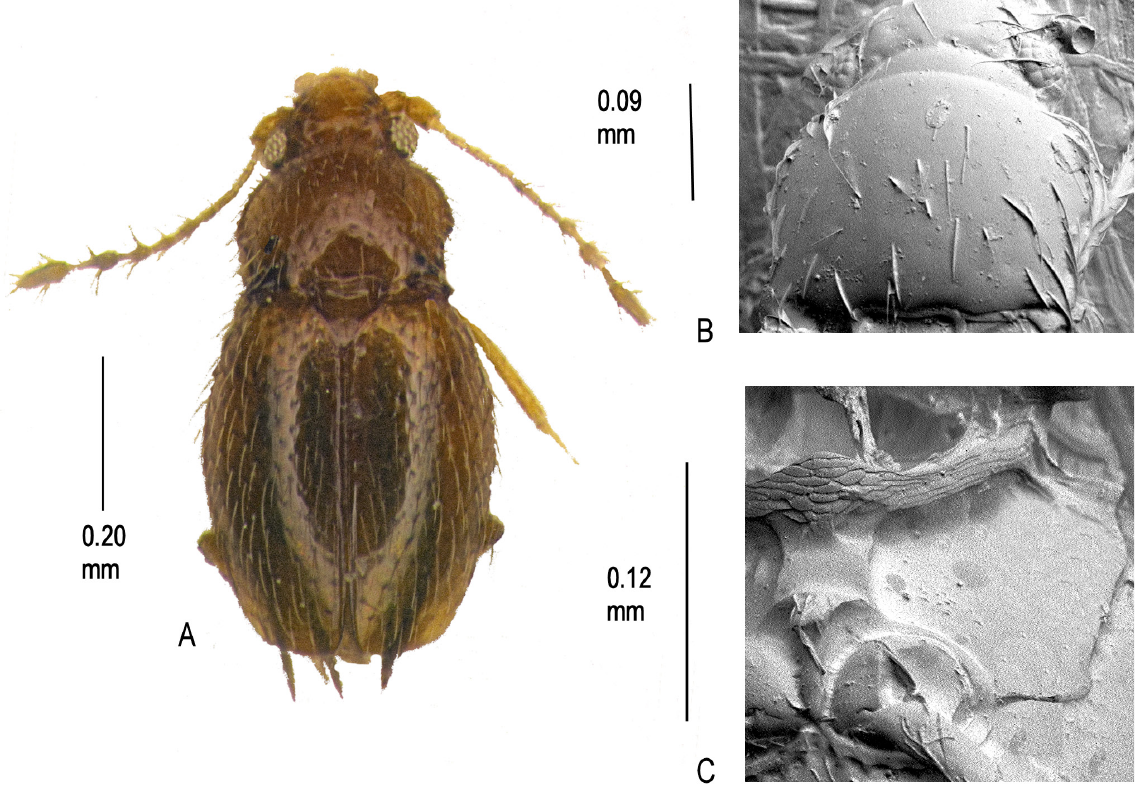
Fig. 100. Cissidium peruviense sp. nov. A . Habitus. B . Pronotum, × 625. C . Mesoventrite showing median process of collar, mid-keel and keel,